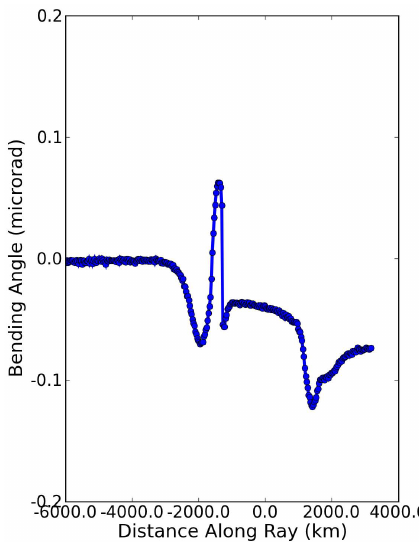
Fig. 10. Residual bending angle after the dual-frequency correction is applied, GAIM case, for a spacecraft at COSMIC altitude.